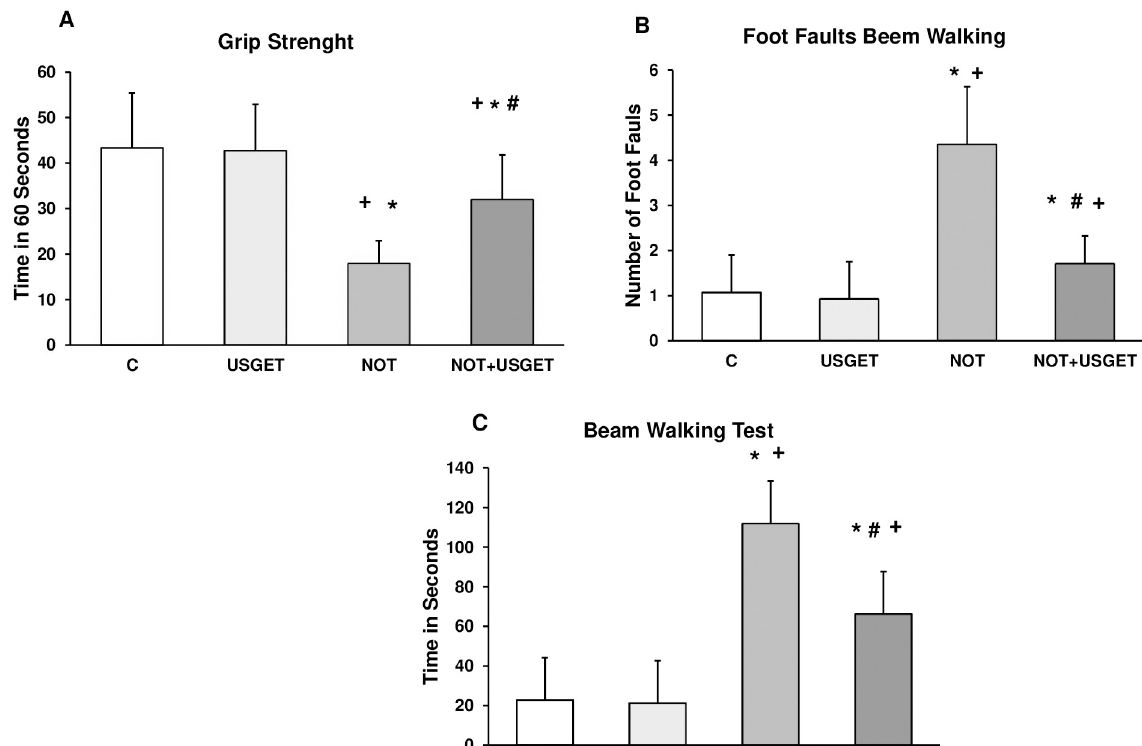
Fig 1. Rats were tested without notexin (control, C or USGTE (6 mA)) or with notexin (NOT) or notexin with USGTE (6 mA) (NOT +USGTE). A: Grip Strength (time in 60 seconds). B: number of foot faults. C: Time to cross the beam (sec). � p < 0.01 vs. control. #p < 0.01 vs.